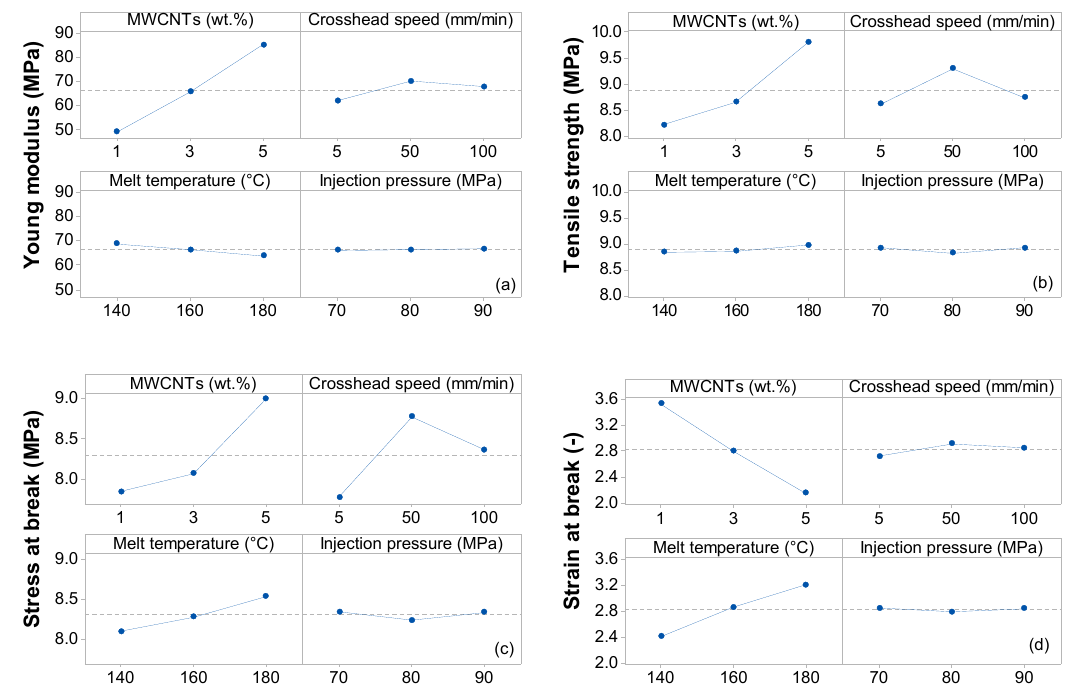
Figure 12. Main effect plots for ( a ) Young modulus, ( b ) tensile strength, ( c ) stress at break, and ( d ) strain at break of EVA/MWCNT composite.